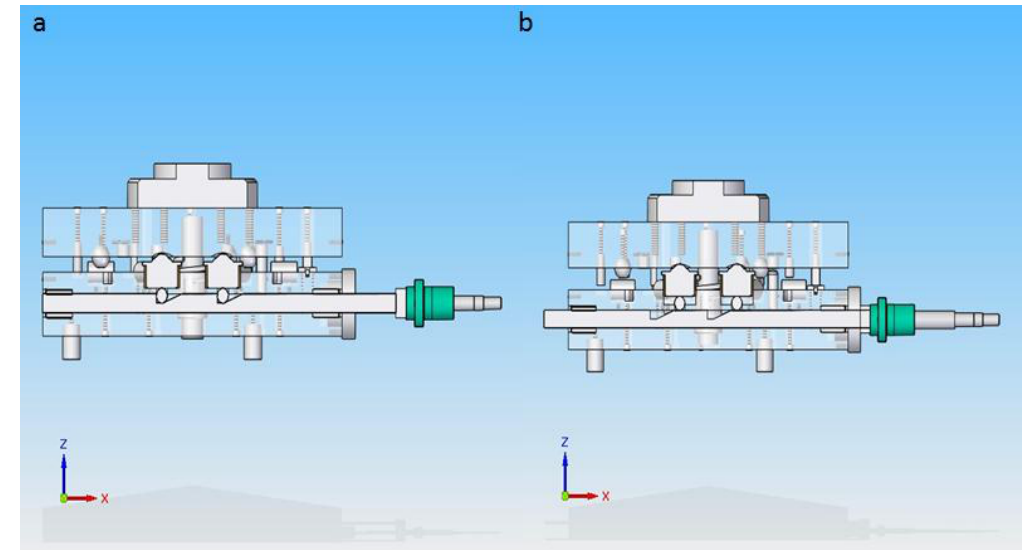
Figure 8. ( a ) Upper platform before elevation (close position); ( b ) Upper platform after elevation (open position), ready to change to a new position.